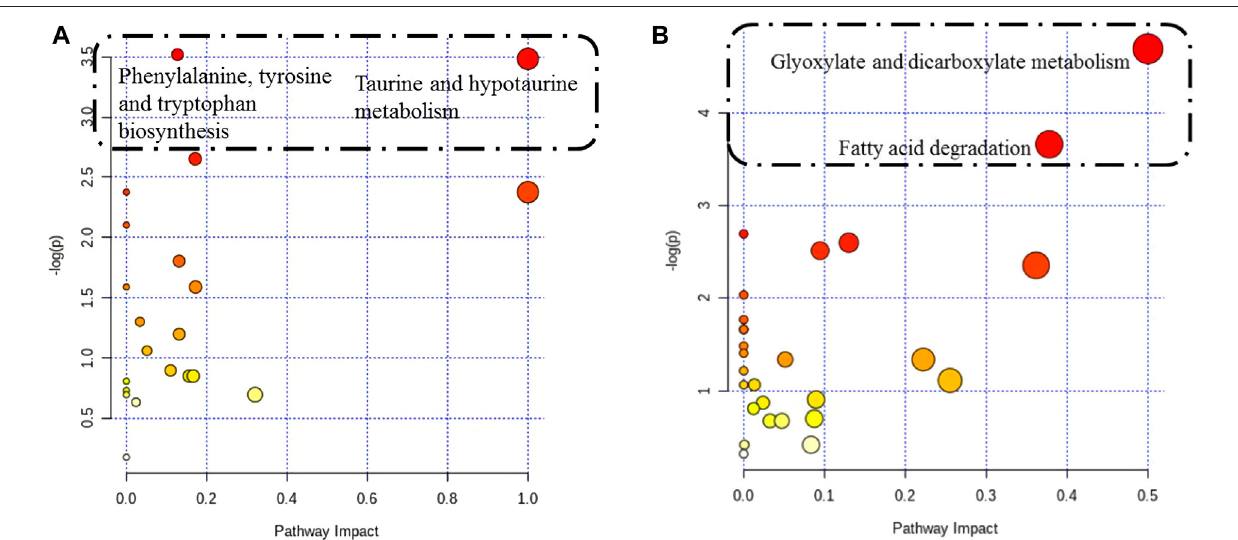
FIGURE 7 | Pathway analysis of differentially altered metabolites in MRSA. (A) Overview of the pathway analysis of the 27 bio fi lm biomarkers. (B) Overview of the pathway analysis of the pharmaceutical markers of MRSA bio fi lms treated with 25 mg/ml AS. The pathway analysis of metabolites with signi fi cant differences was performedusingMetaboAnalyst3.0.Thebubblechartofthepathwayenrichmentanalysisshowsallmatchedpathwaysaccordingtothepathwayimpactvalues( X -axis) of the topological analysis and p -values ( Y -axis) of the pathway enrichment analysis. Each node represents a biological pathway. The bubble area (radius) is proportional to the impact value of each pathway, with the color denoting the signi fi cance from the highest in red to the lowest in white. The nodes in the dashed box represent the biological pathways that are signi fi cantly related to bio fi lm markers.